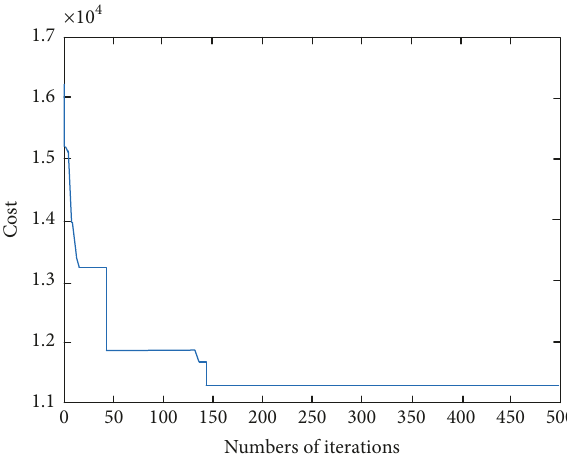
Figure 3: Convergence of the solution